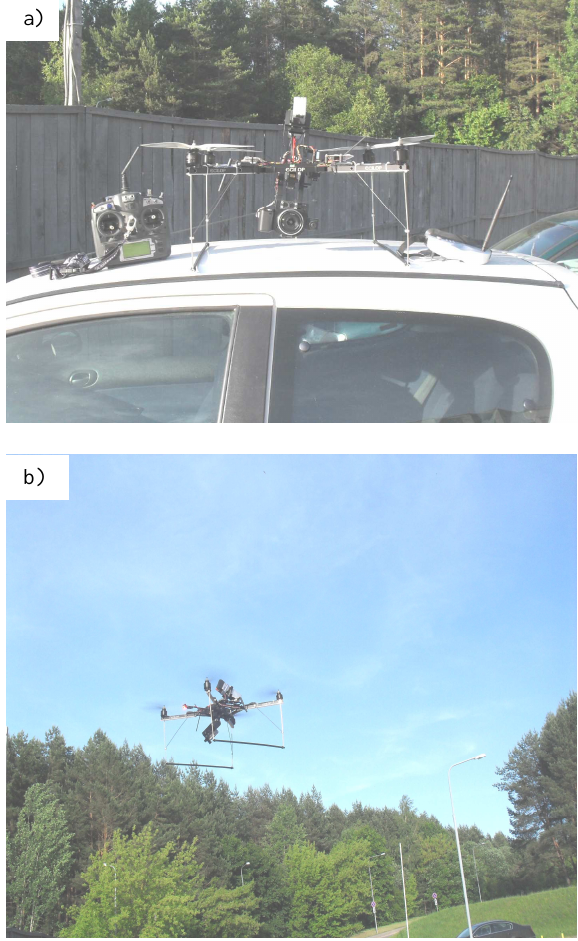
Figure 2. UAV used for Photogrammetry: a) UAV